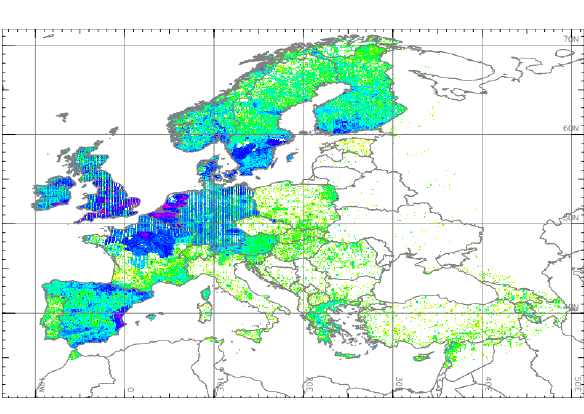
Figure 2: Plants occurrences for Europe per country extracted from GBIF data (website accessed Dec 2014). The areas in white have zero occurrences recorded in the GBIF database. A higher sampling density is represented moving from green to blue colour. This figure was developed by GRASS GIS software (Neteler et al., 2012).